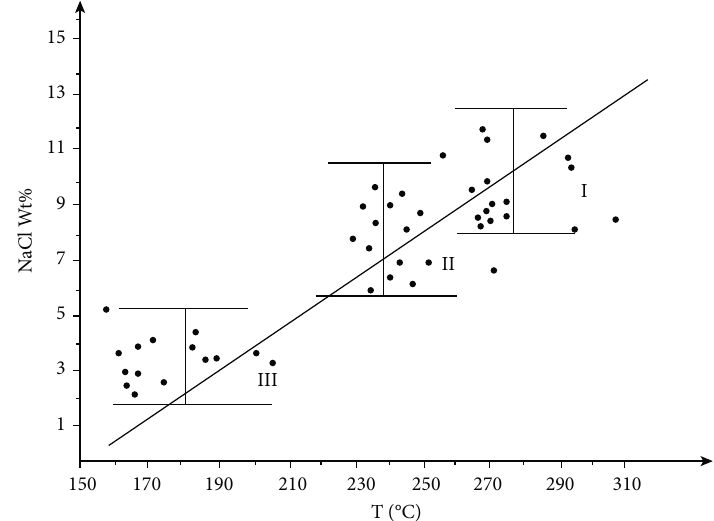
Figure 4: Main homogenization temperatures.